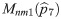
A. The model structure Mnm1(p^7) fitted to data.The figure shows mean values and standard error (SE) from primary stimulus in the intensity experiment. Here the model was forced to display an initial dip and a post-peak undershoot. B. Glucose and oxygen in Mnm1(p^7). Reduced, but not depleted, glucose level triggers blood flow increase. The increased oxygen metabolism after stimulus causes the initial dip. C. Vasoconstrictive inhibition of blood flow during the initial dip does no longer occur.